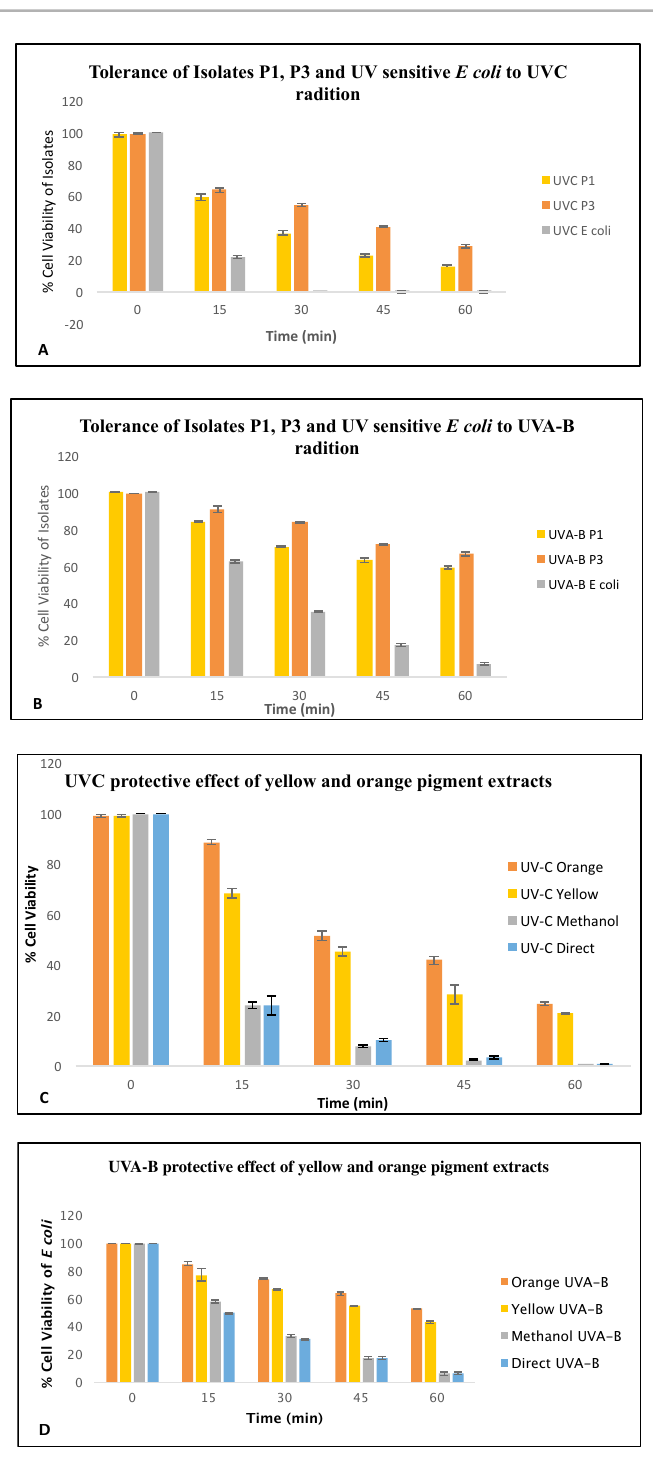
FIGURE 3 – Tolerance of the isolates P(1) and P(3) to UV radiation; UV-C radiation (A) and UVA-B radiation (B). UV protective effect of the methanolic pigment extracts; UV-C radiation (C) and UVA-B radiation (D). Each bar represents three trials expressed as mean ±